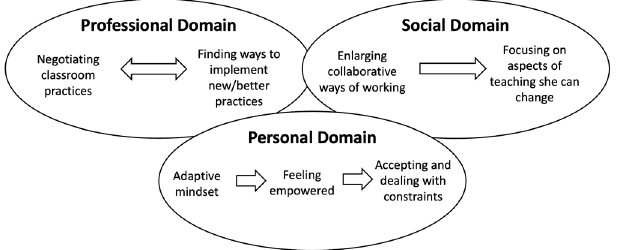
FIG. 2. Cleopatra ’ s trajectory characterization in the Bell and Gilbert